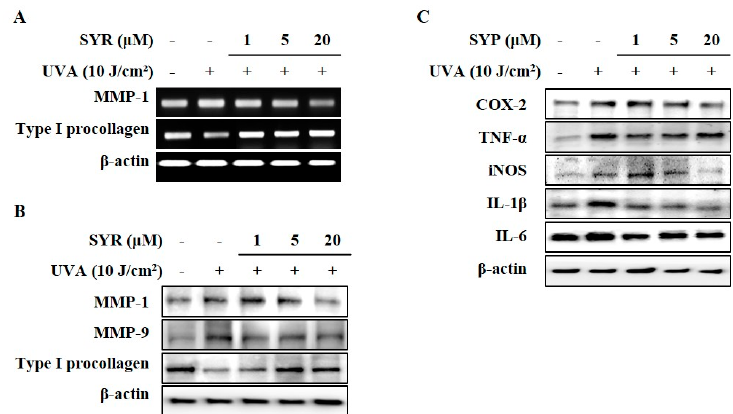
Figure 2. Effect of SYR on UVA-induced mRNA and protein expressions of MMPs, type I procollagen, and pro-inflammatory mediators in HaCaT keratinocytes. Cells were exposed to UVA radiation (10 J/cm 2 ) and treated with given concentrations of SYR for 24 h. ( A ) mRNA expressions of MMP-1 and type I procollagen were analyzed with RT-PCR. ( B ) Protein levels of MMP-1, -9 and type I procollagen ( C ) and pro-inflammatory mediators (COX-2, TNF- α , iNOS, IL-1 β and IL-6) were determined by Western blotting. β -Actin was used as an internal control for RT-PCR and Western blotting. Retinoic acid was used as a positive control.